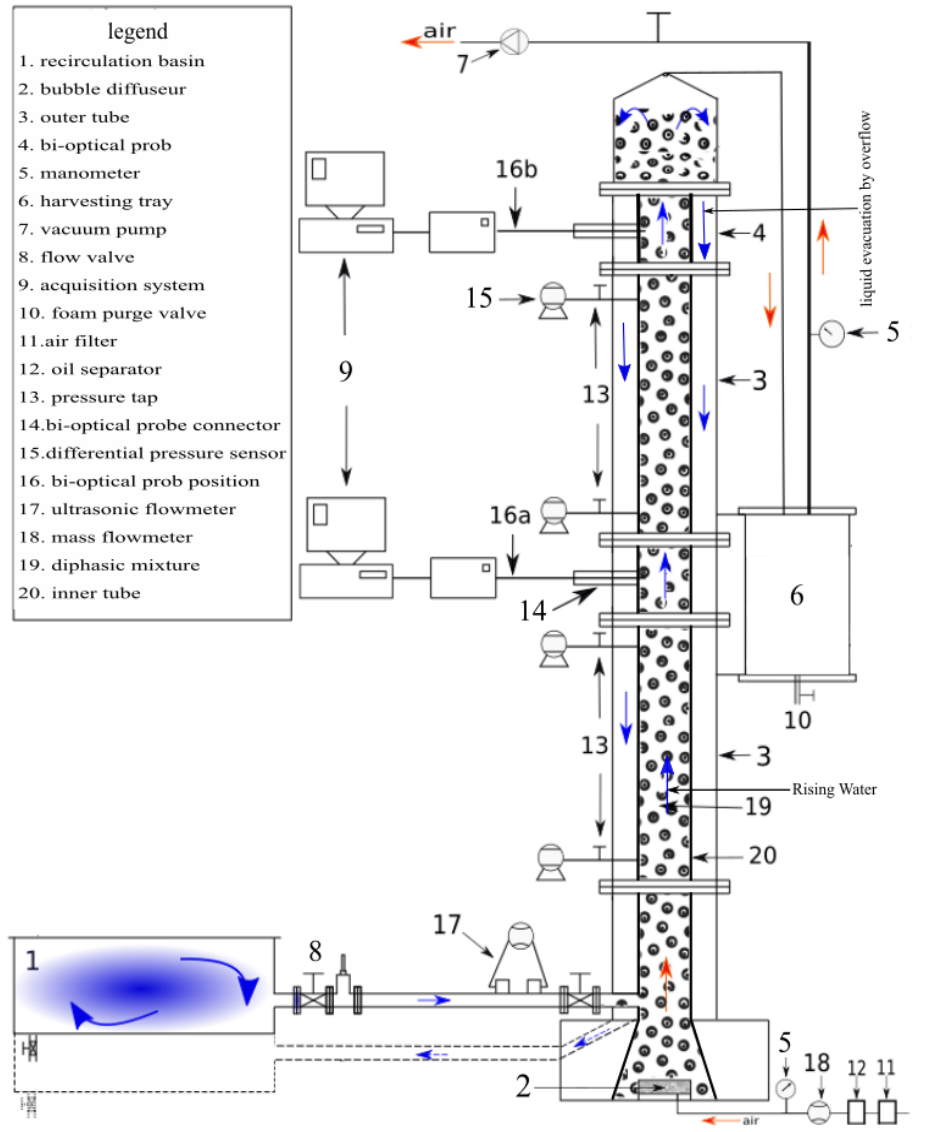
Figure 1. Experimental